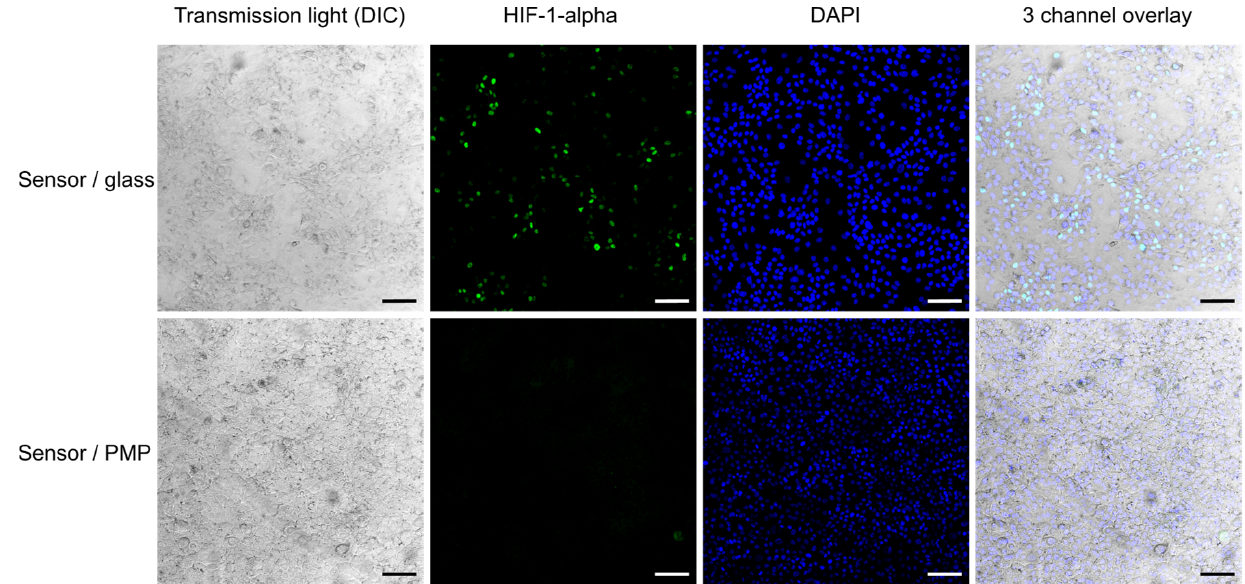
Figure 6. HIF-1 α activation. Activation of the HIF-1 α transcription factor in A549 cells cultured in sensor/glass and sensor/PMP devices (see Figure 2 and Section 2.2.1 for details on device designs) after the last measurement of oxygen concentration at 75 h after sealing of devices (see Figure 7). Cells were fixed with formaldehyde before fluorescent staining. The second column shows the presence of activated HIF-1 α (green) in numerous cells cultured in the sensor/glass device, while almost none was observed in the sensor/PMP device. Transmitted light images and an overlay with DAPI nuclei staining (blue) show the morphology of a highly confluent cell monolayer. Scale bar: 100 µ